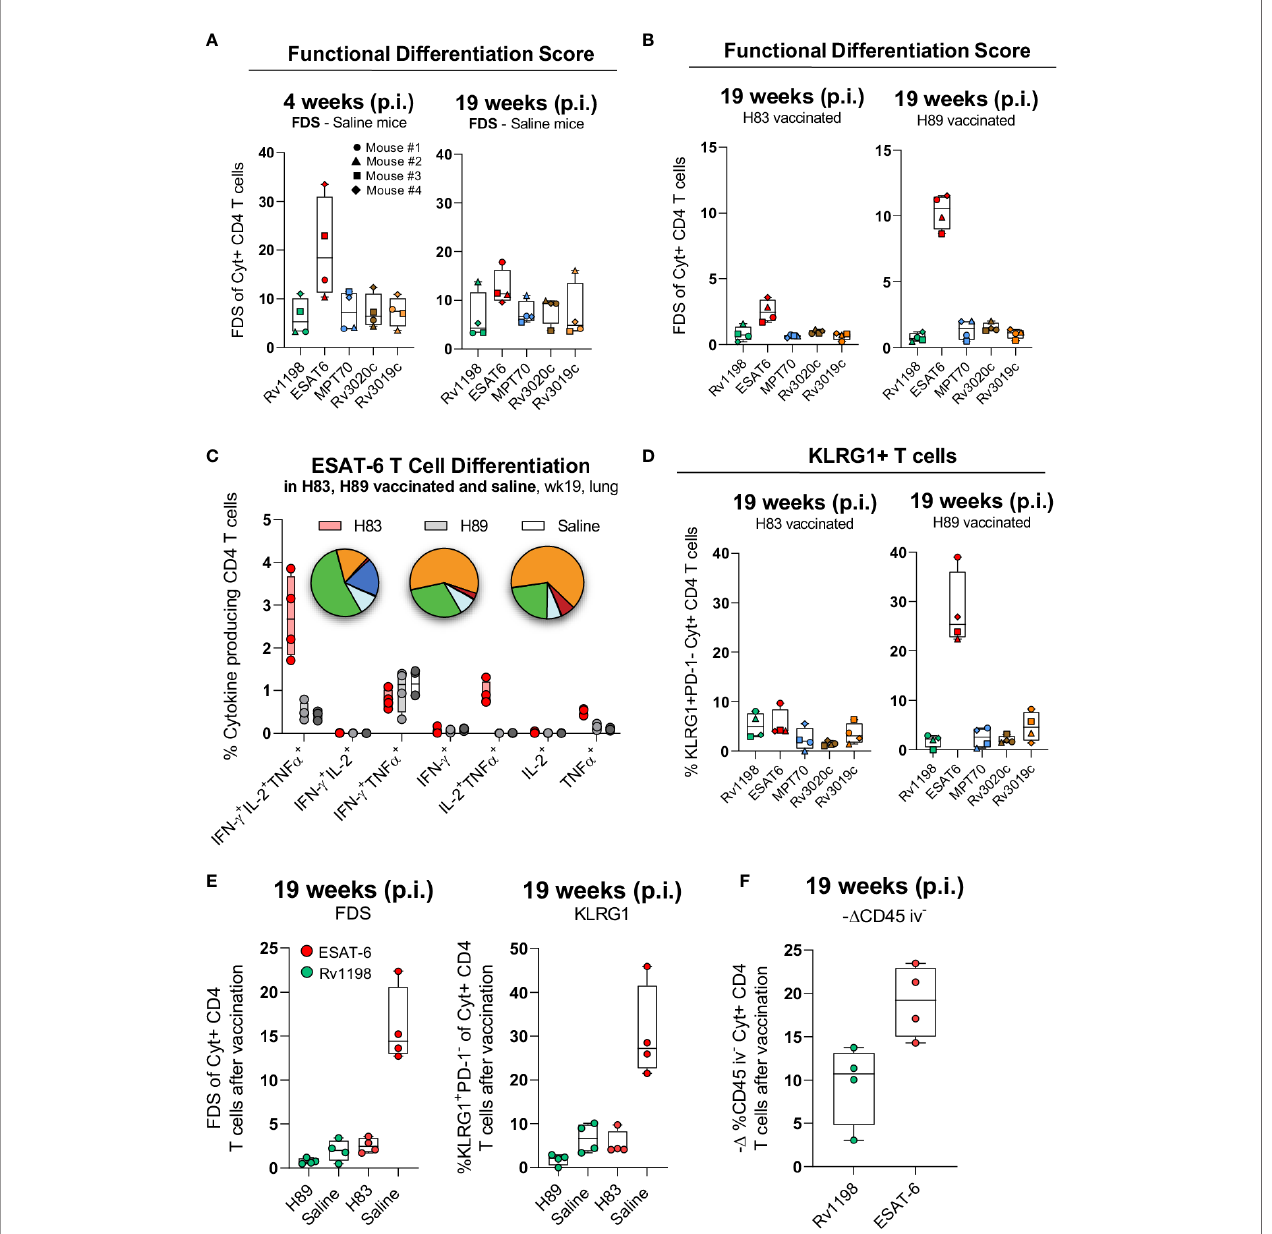
FIGURE 4 | H83 vaccination rescues ESAT-6-speci fi c CD4 T cells from terminal differentiation. (A) The Functional Differentiation Score (FDS) of Rv1198, ESAT-6, MPT70, Rv3020c and Rv3019c-speci fi c CD4 T cells from Mtb infected mice at week 4 and 19 after Mtb challenge (n = 4). FDS represents the ratio of all IFN- g producing CD4 T cell subsets divided by subsets producing other cytokines (IL-2, TNF a ), but not IFN- g (high FDS = high IFN- g production). (B) FDS of Rv1198, ESAT-6, MPT70, Rv3020c, and Rv3019c-speci fi c CD4 T cells from H83 and H89 vaccinated mice at week 4 and 19 after Mtb challenge (n = 4). (C) The distribution of cytokines that ESAT-6 speci fi c CD4 T cells produce after H83 (red), H89 (gray), or saline vaccination (white) 19 weeks post Mtb infection (n = 4). Pies nomenclature: green (IFN- g + , IL-2 + , TNF a + ), orange (IFN- g + , TNF a + ), red (IFN- g + ), dark blue (IL-2 + , TNF a + ), and light blue (TNF a + ). (D) Percentage of KLRG1 + PD-1 - expressing Rv1198, ESAT-6, MPT70, Rv3020c, and Rv3019c-speci fi c CD4 T cells from H83 and H89 vaccinated mice 4 and 19 weeks after Mtb challenge (n = 4). (E) (left) FDS and (right) KLRG1 + PD-1 - expressing (right) ESAT-6 and Rv1198-speci fi c CD4 T cells. (F) Increase in lung homing capacity of ESAT-6 and Rv1198- speci fi c CD4 T cells after vaccination shown as – delta difference in CD45 iv - staining. The delta graph for CD45 iv - was calculated as the mean value for ESAT-6 and Rv1198 in infected mice subtracted the value for ESAT-6 in H83 vaccinated mice and Rv1198 in H89 vaccinated mice 19 week post infection (n = 4). Graphs are visualized as box plots showing all points with whiskers indicating minimum and maximum